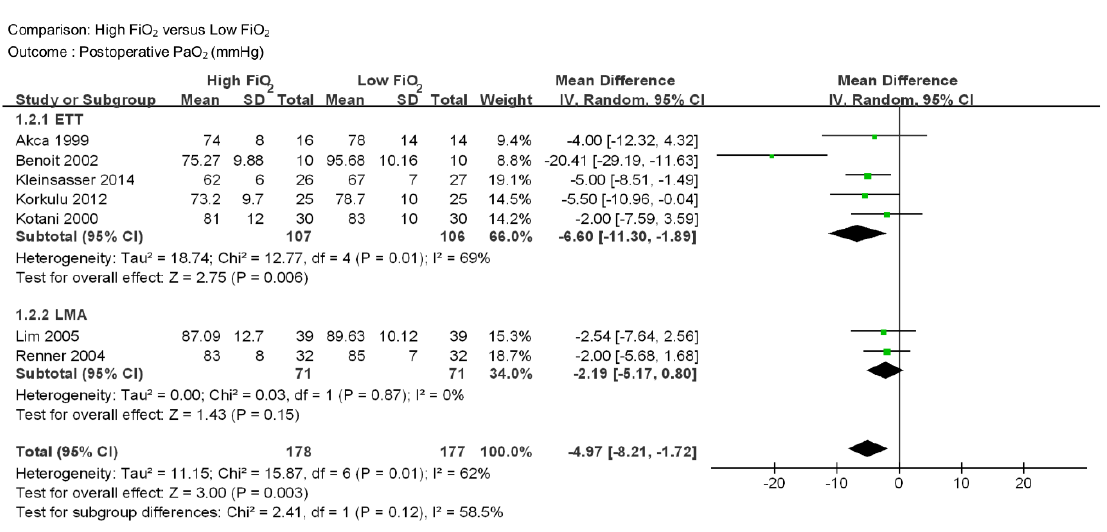
Figure 3. Forest plot for postoperative PaO 2 (mmHg) in patients with high intraoperative inspired oxygen concentration versus low intraoperative inspired oxygen concentration. ETT = Endotracheal tube, LMA = Laryngeal Mask airway, CI = confidence interval.